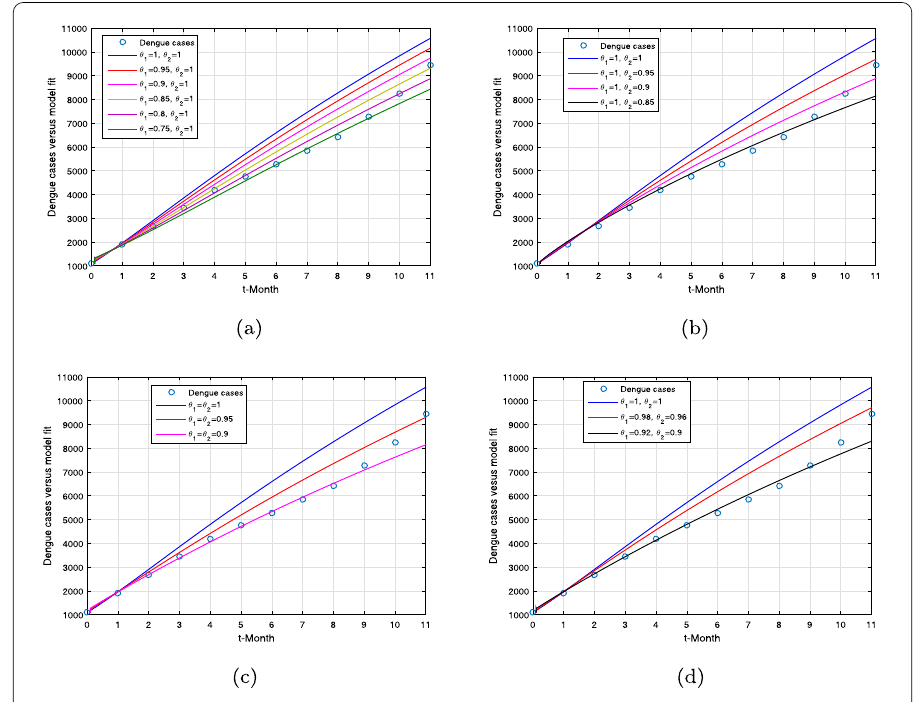
Figure 1 Model versus data fitting for different values of fractional order θ 1 and fractal order θ 2